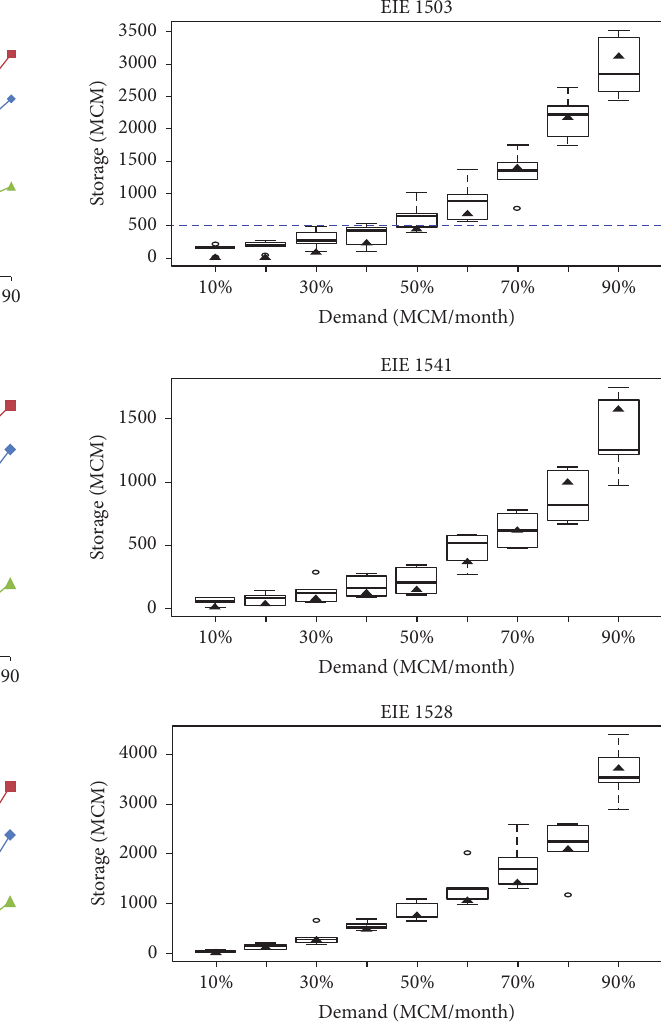
Figure 12: Sequent peak results based on the demand of 10–90% of mean discharge from spatial approach. The triangle denotes the observed